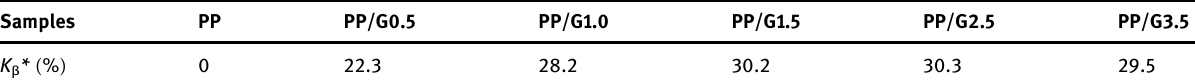
Table 2: The relative content of β crystal form of samples Samples